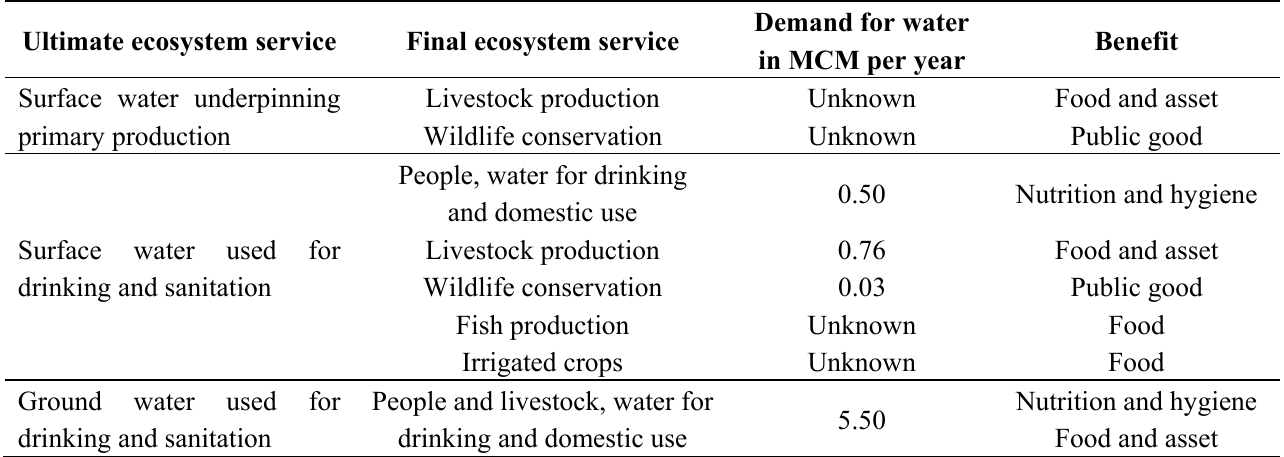
Table 1. Ecosystem services provided by the water in the Lorian Swamp, their usage and benefits, and the estimated demand for water for provision of final ecosystem